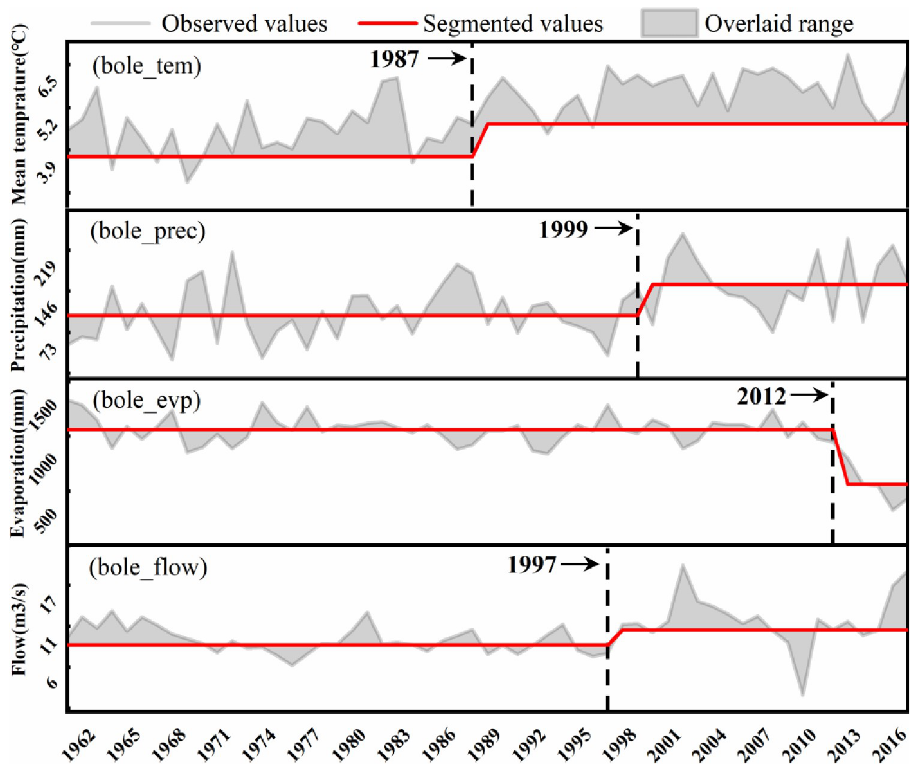
Fig 4. Temporal changes of hydroclimatic variables at Bole station ( p < 0.05). The gray line, red line, and gray area represent the runoff observation, breakpoint segmentation value, and coverage area,